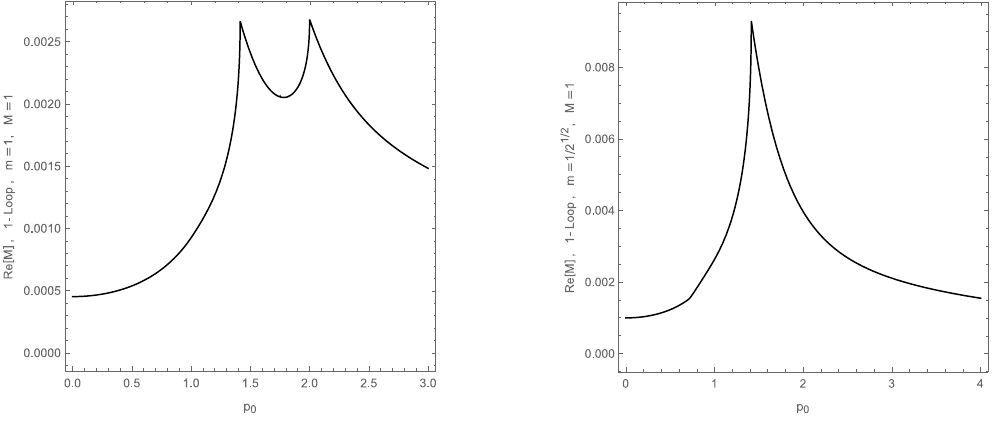
Figure 2 . Left panel: real part of the amplitude around the pinching at k 0 m = 3 and M = 1 . Right panel: real part of the amplitude for m = 0 . 1 , M = 1 . The plot explicitly shows that the amplitude is nonanalytic also at the threshold p